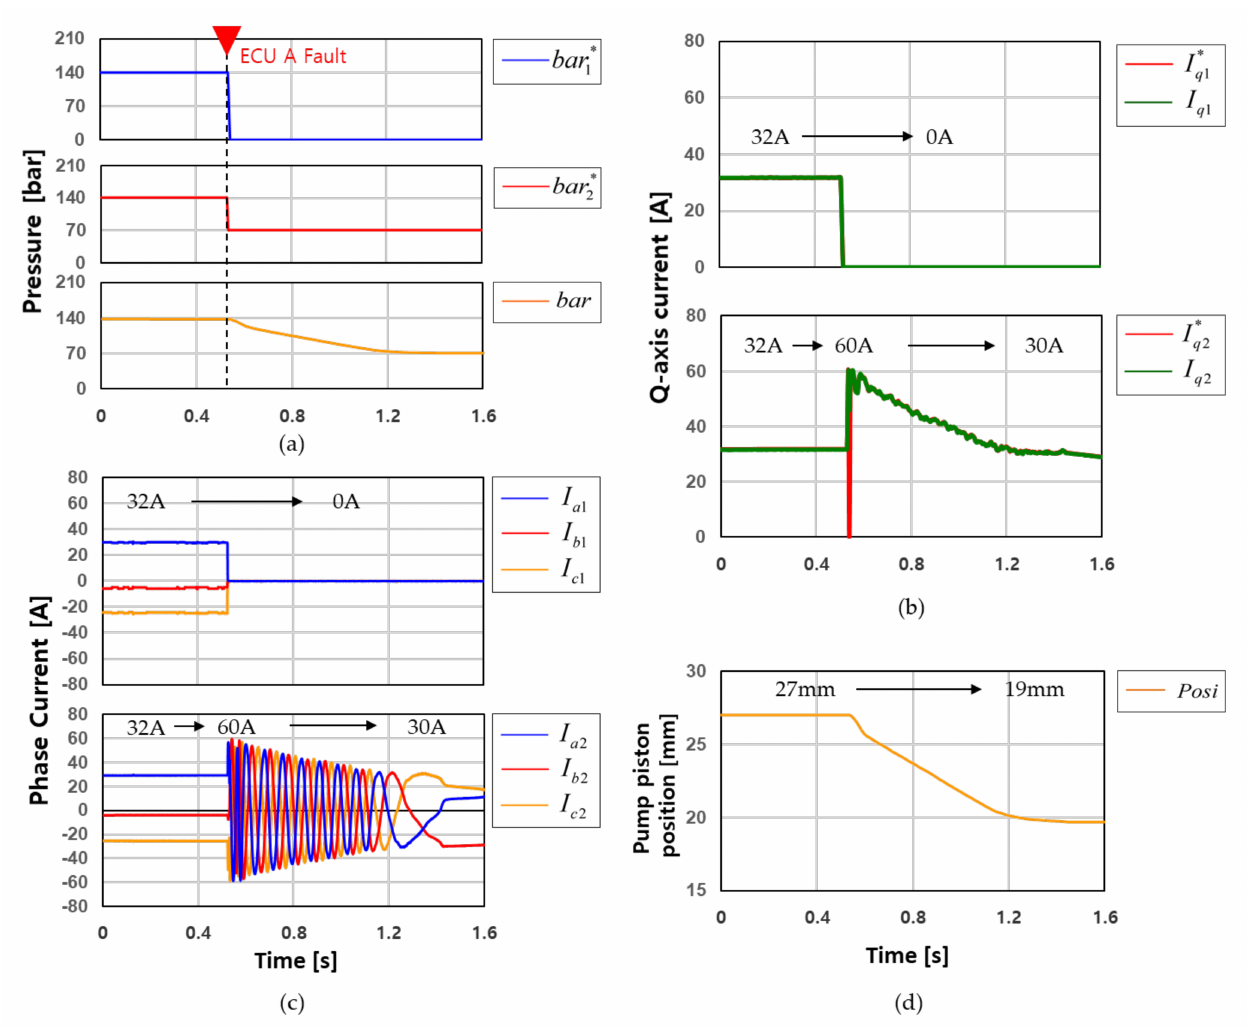
Figure 14. Measurement results when the malfunctioning of ECU A occurs: ( a ) target pressure ( bar ∗ , bar ∗ ) and measured pressure (bar); ( b ) q − axis current command value ( I ∗ 2 1 q − axis current value ( I q 1 , I q 2 ); ( c ) measured three-phase current ( I a 1 , I b 1 , I c 1 ) , ( I a 2 , I b 2 , I c 2 ) ; ( d ) cal- culated pump piston